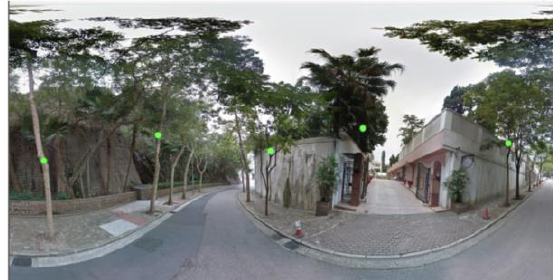
Figure 11. Green dot represents position of the tree in equirectangular image